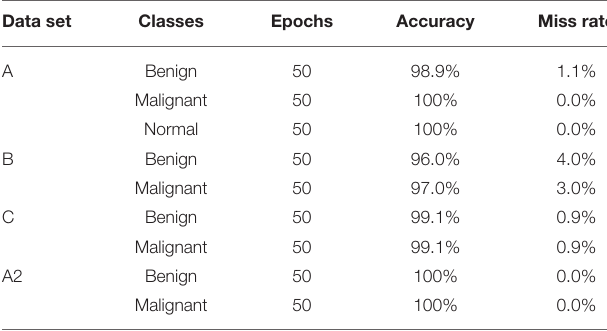
TABLE 4 | Training model on 50 epochs class-wise.